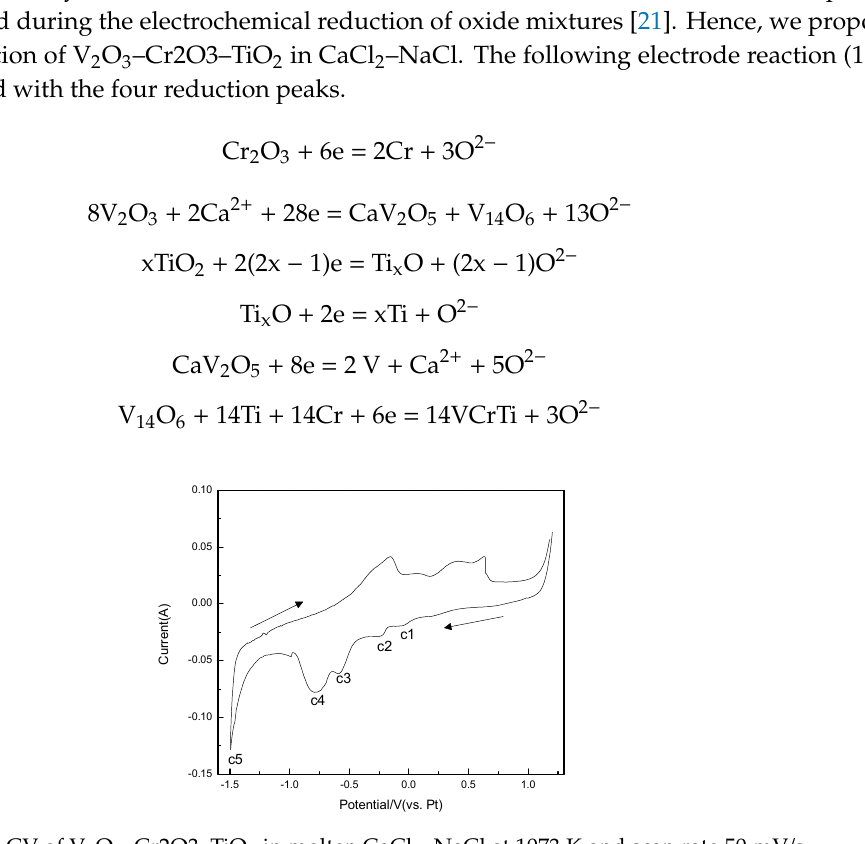
Figure 6. CV of V 2 O 3 –Cr2O3–TiO 2 in molten CaCl 2 –NaCl at 1073 K and scan rate 50 mV/s.